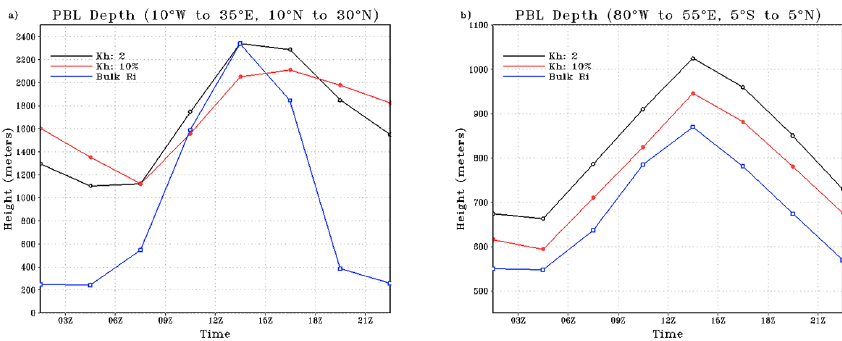
Figure 1. Diurnal cycle of JJA mean PBL depth averaged over northern Africa from 10 ◦ W to 35 ◦ E longitude and from 10 to 30 ◦ N latitude (a) and tropical South America from 80 ◦ W to 55 ◦ E longitude and from 5 ◦ S to 5 ◦ N (b) .